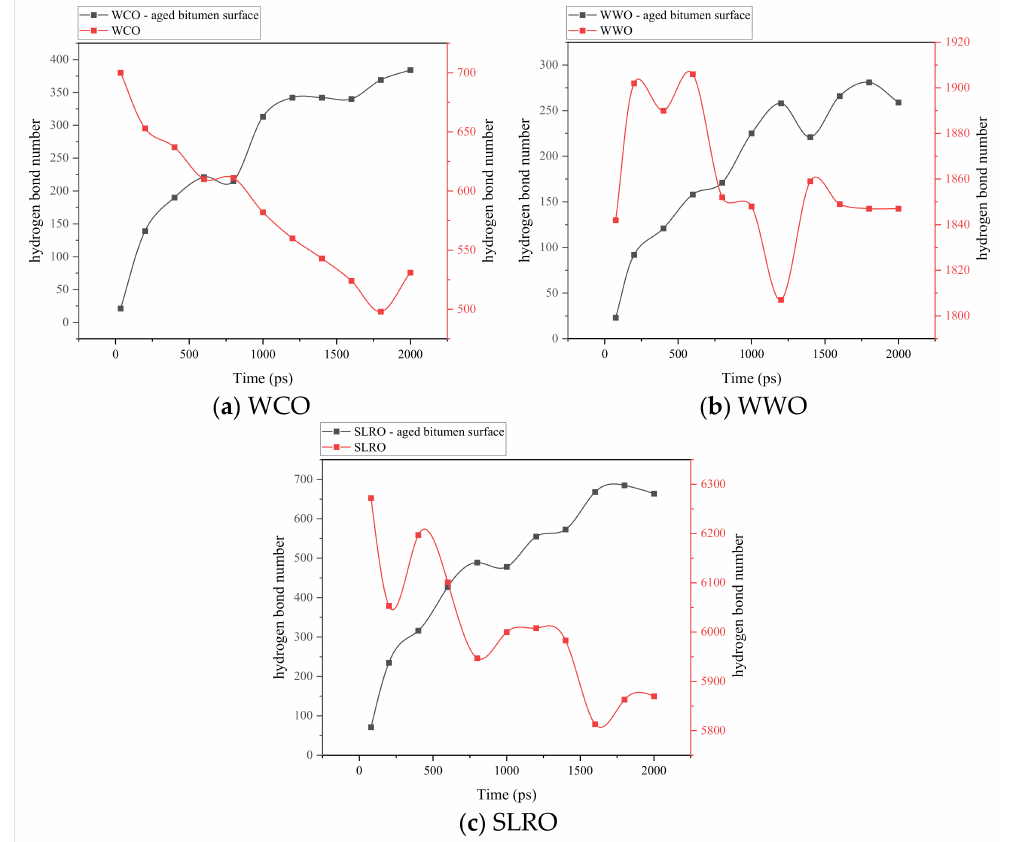
Figure 16. The number of hydrogen bonds in bio-oil droplets and between the droplets and aged bitumen